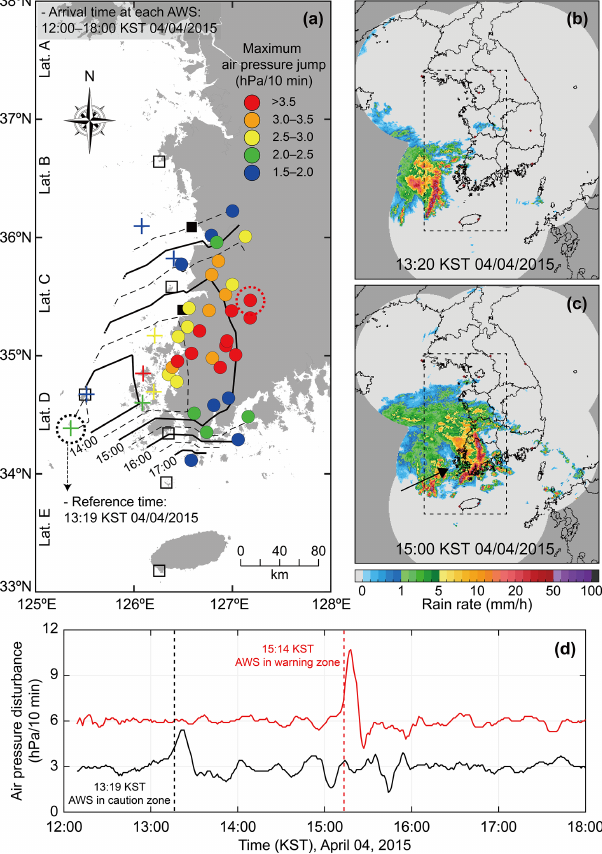
Figure 8. Propagation of the air pressure jump on 4 April 2015. (a) Isochrone map. Circles mark multiple AWSs where the air pres- sure jump arrived from 12:00 to 18:00KST. Colors of the circles denote the maximum intensity. The reference time is the first arrival time. Thick black lines and black dashed lines indicate isochrones (1h and 30min) from the reference time. Black squares mark the tide gauges where the meteotsunamis arrived (see Table 1). Black empty squares are the tide gauges located in harbors. Radar im- ages at (b) 13:20 and (c) 15:00 KST on 4 April 2015, respectively. Dashed squares indicate same area as the isochrone map. (d) The time series of the air pressure disturbances observed at two AWSs located on propagation path of the air pressure jumps (see black and red dashed circles in the isochrone